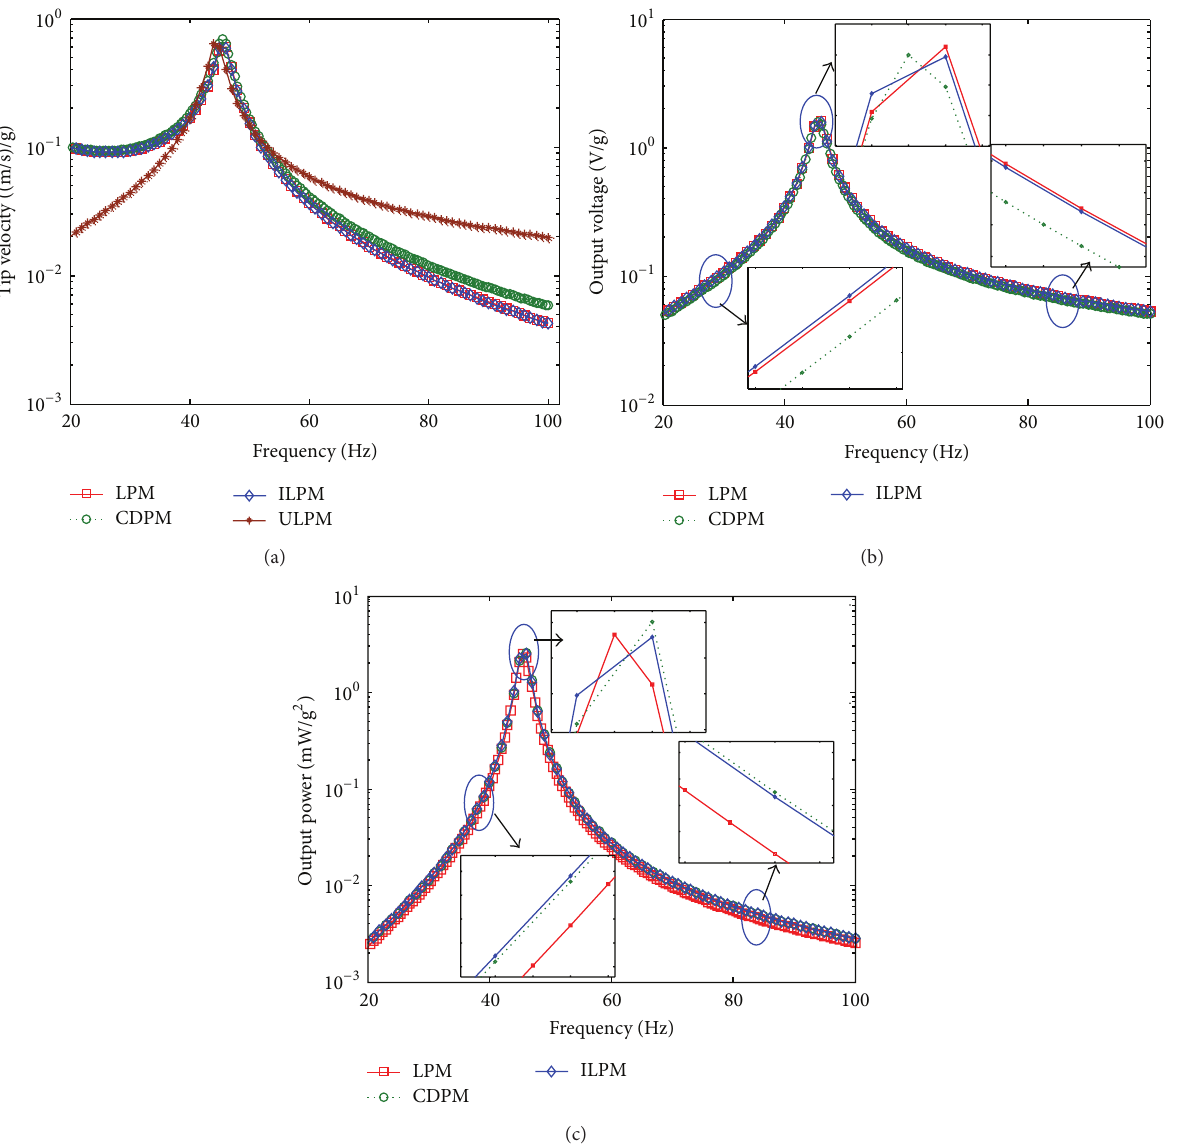
Figure 12: Comparison of analytical results of LPM, CDPM, ULPM, and ILPM when 𝑅 𝐿 = 1 k Ω : (a) tip velocity, (b) output voltage, and (c) output